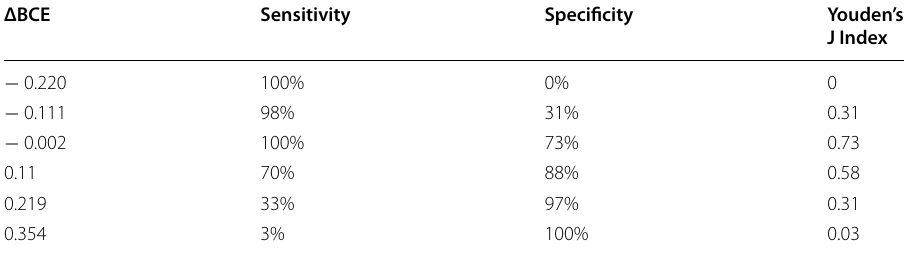
Table 4 Sensitivity, specificity and Youden’s J index for measurements of